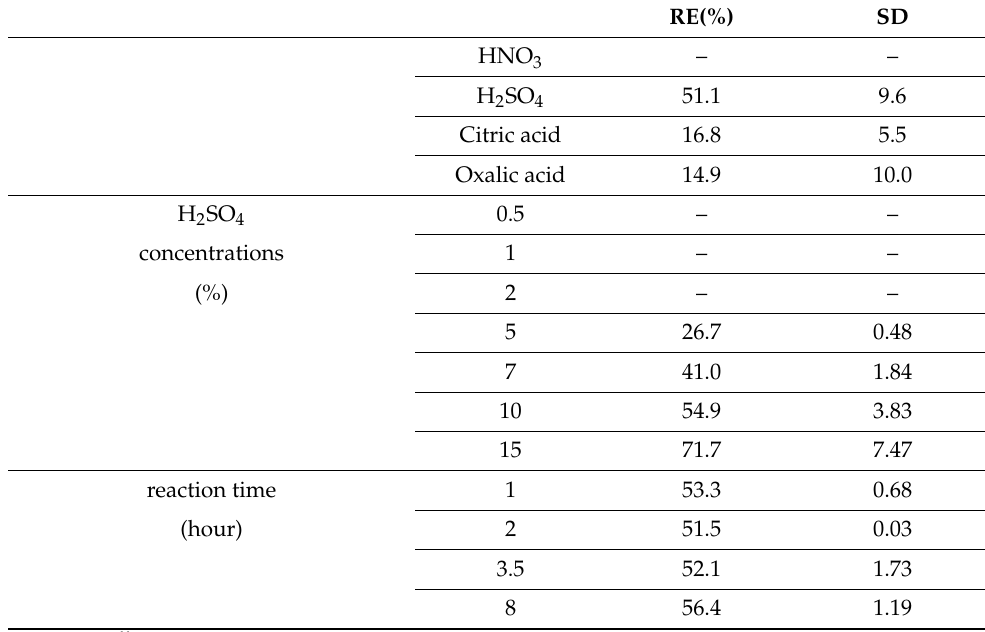
Table 5. The removal efficiency of TN from swine